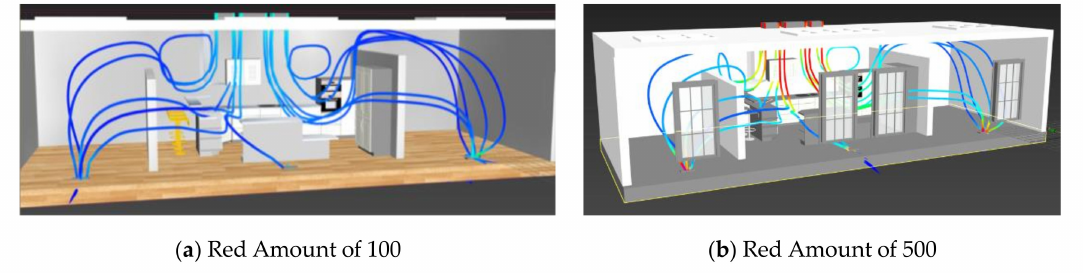
Figure 12. Red Amount of ( a ) 100 vs. ( b ) 500.